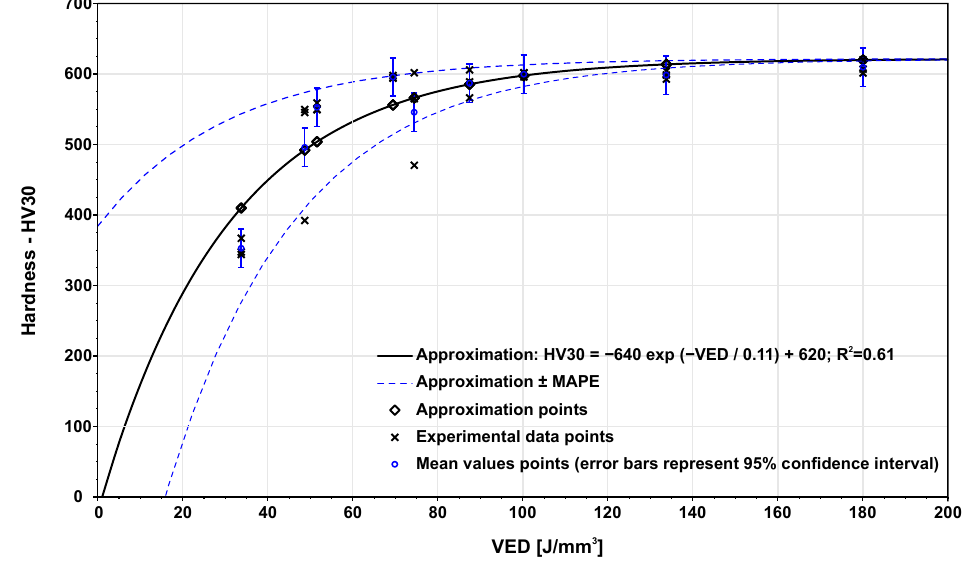
Figure 10. Mathematical relation between HV30 hardness and applied VED. Mean values of porosity and hardness were also displayed in P-v space (see Figure 11) which is often used for evaluation of process parameters for L-PBF technologies. In our case, this display offers better understanding of our results for wider